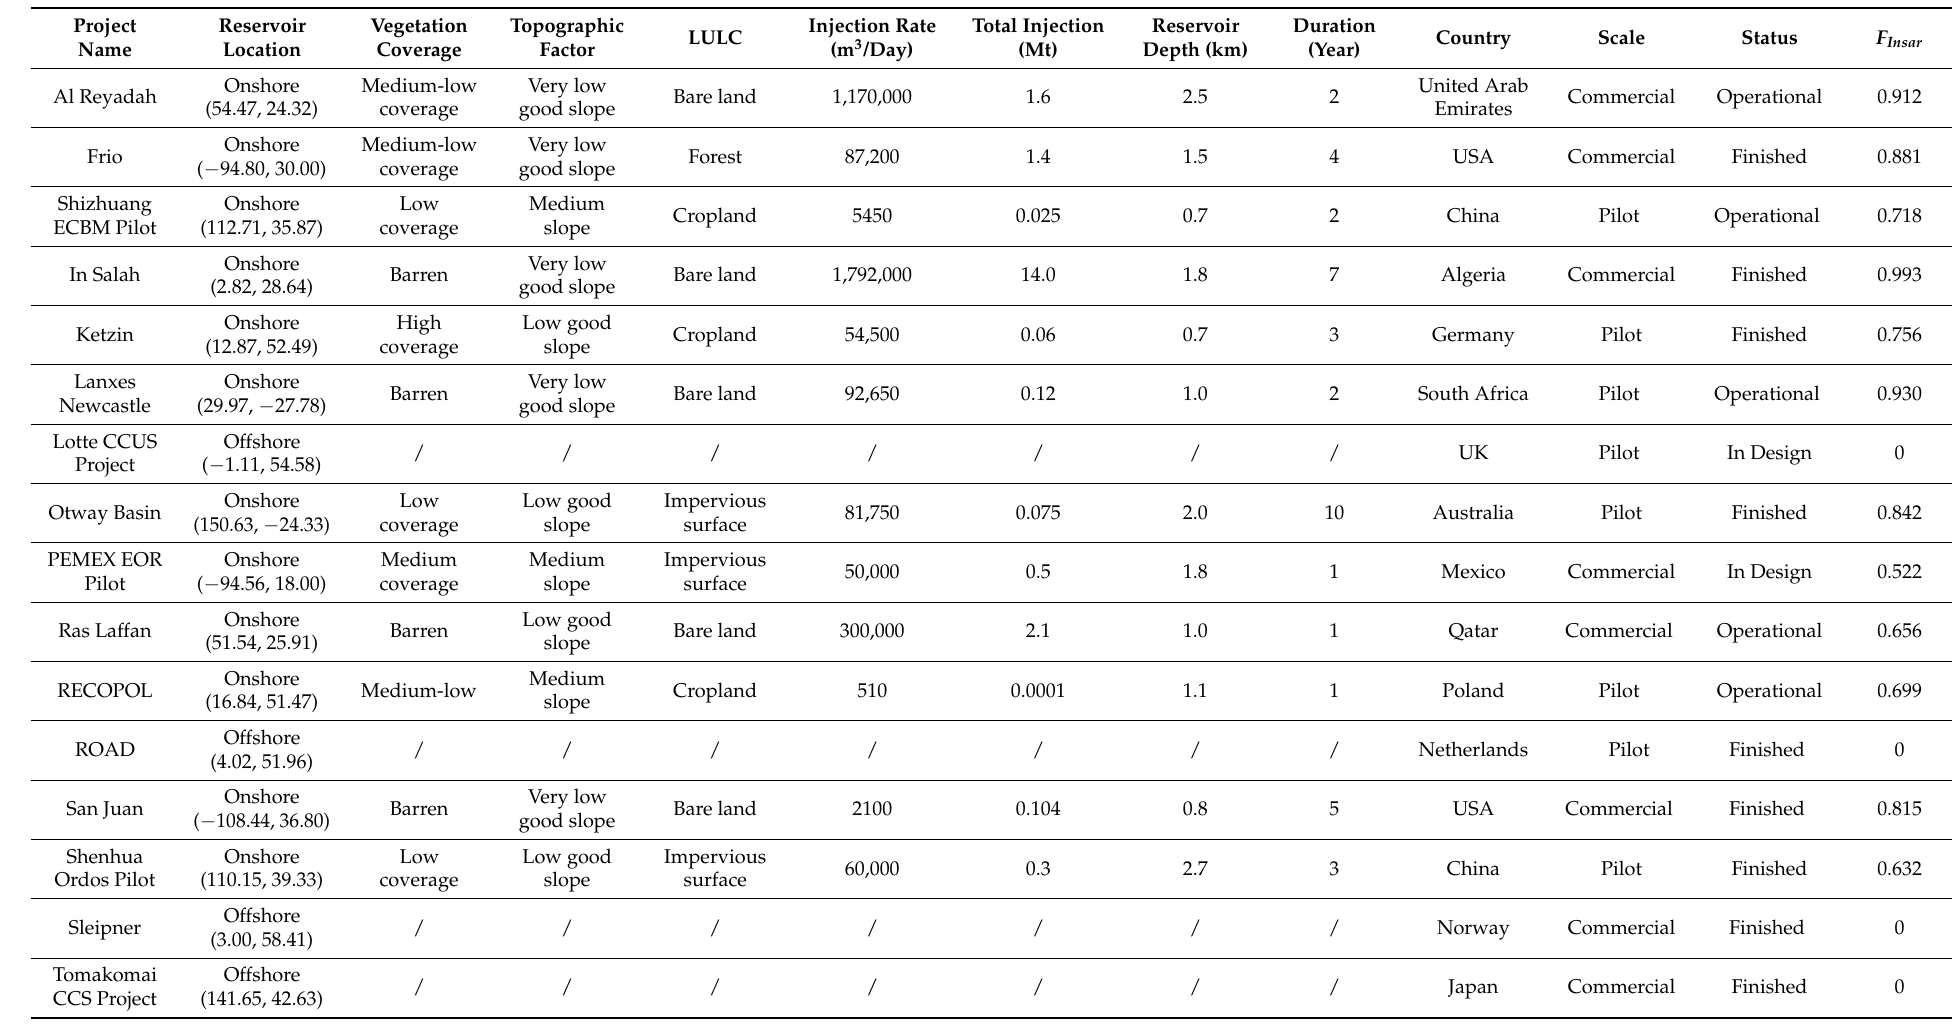
Table 10. Typical global CCS area parameters and feasibility